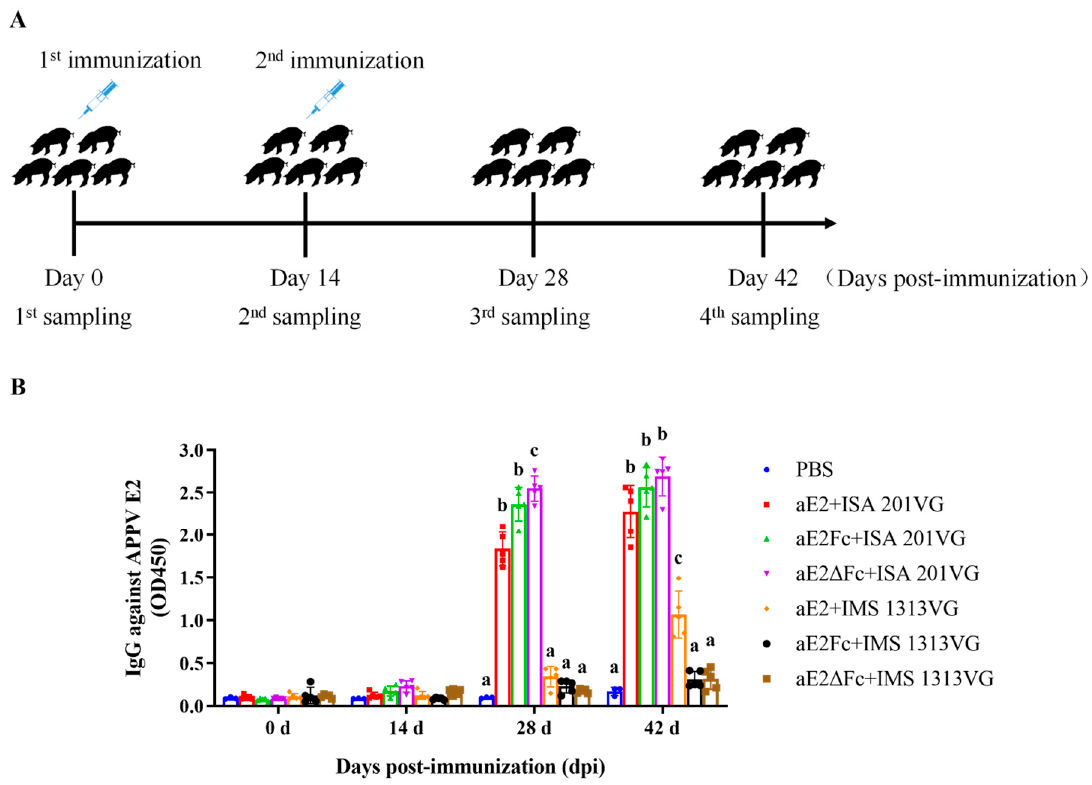
Figure 5. Detection of APPV E2-specific antibodies. ( A ) Schematic outline of the experimental design. ( B ) APPV E2-specific IgG detected via indirect ELISA at indicated dpi. Different letters (a, b, c) indicate a statistically significant difference between different experimental groups ( p < 0.05). Experiments were conducted independently in triplicates. Data are represented as the mean ± SD (n = 5).